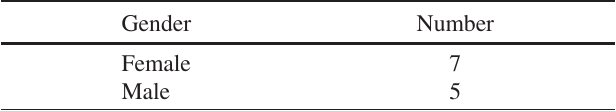
TABLE I. Genders of the learning assistants interviewed.